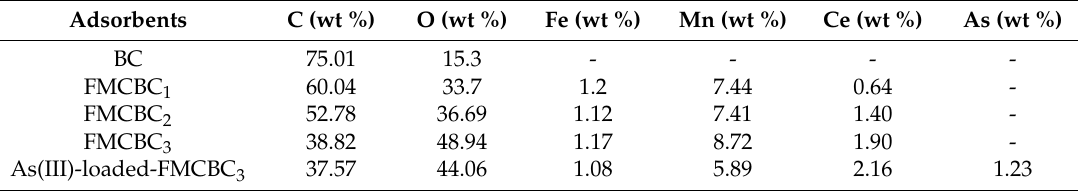
Table 2. The X-ray photoelectron spectroscopy of FMCBCs (%).